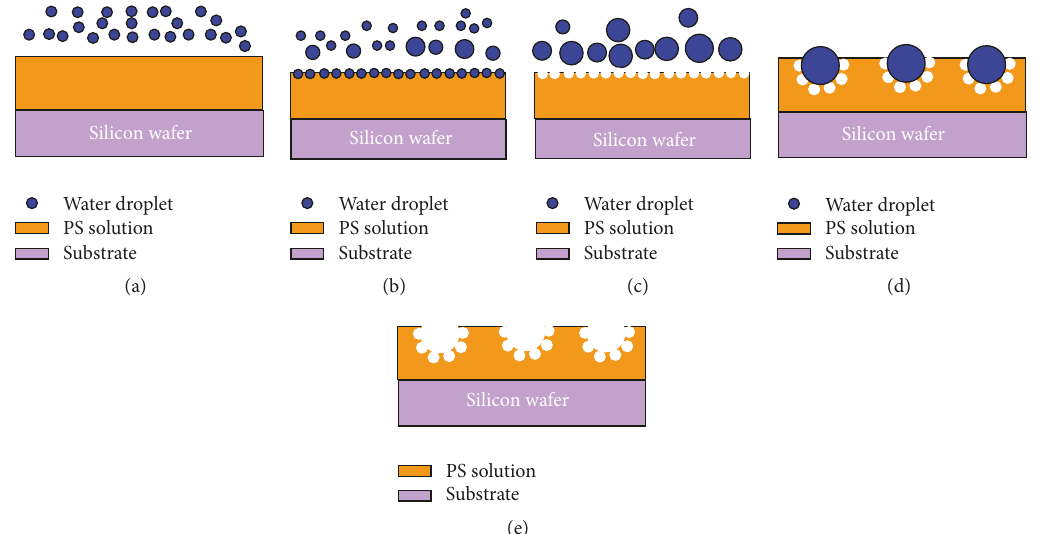
Figure 6: Schematic illustration for the formation of the hierarchical structure. (a) Water droplets approaching the PS solution. (b) Condensation of thefirstlayer droplets. (c) Coalescence of thelarger droplets. (d)Successive condensation and sedimentation ofthecoalesced droplets. (e) Formation of the final hierarchical